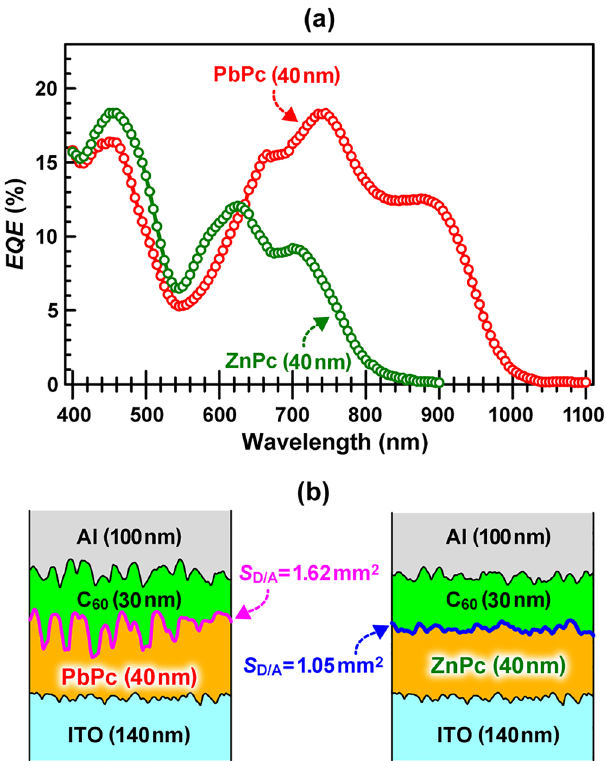
Figure 6. ( a ) EQE action spectra of [ITO/PbPc/C 60 /Al] (red) and [ITO/ZnPc/C 60 /Al] (green) OSCs and ( b ) schematic representation of both cross-sectional cell structures illustrated on the basis of AFM results (Fig. S6). The donor/acceptor effective interface area ( S D/A ) for PbPc/C 60 and ZnPc/C 60 bilayer heterojunctions with an irradiation area of 1 × 1 mm 2 was estimated to be 1.62 and 1.05 mm 2 from the AFM depth profiles (2 × 2 mm 2 ) of PbPc and ZnPc films on ITO, respectively, by assuming that those bilayer heterojunctions are uniformly formed on